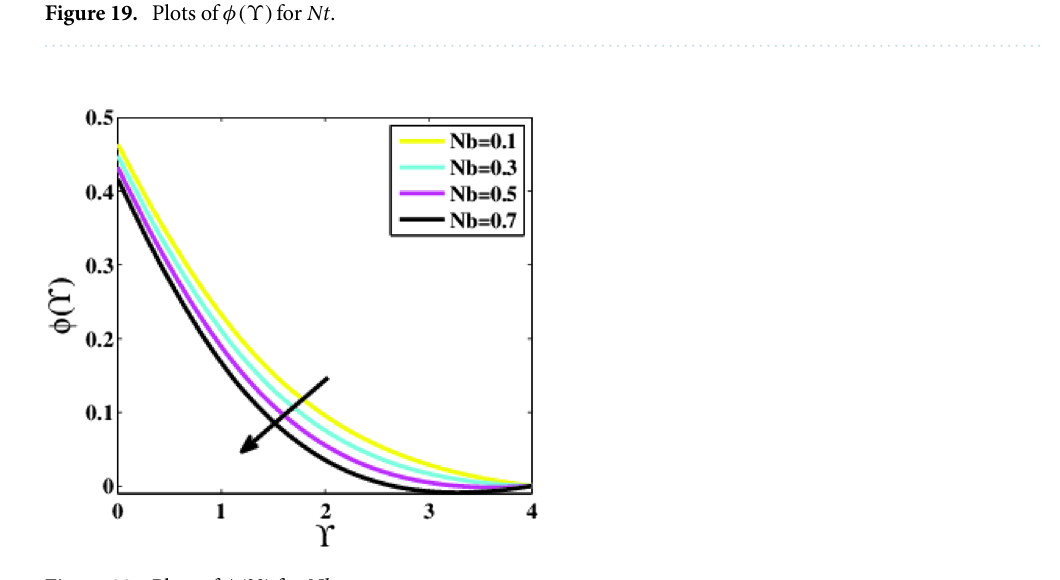
Figure 20. Plots of φ(ϒ) for Nb